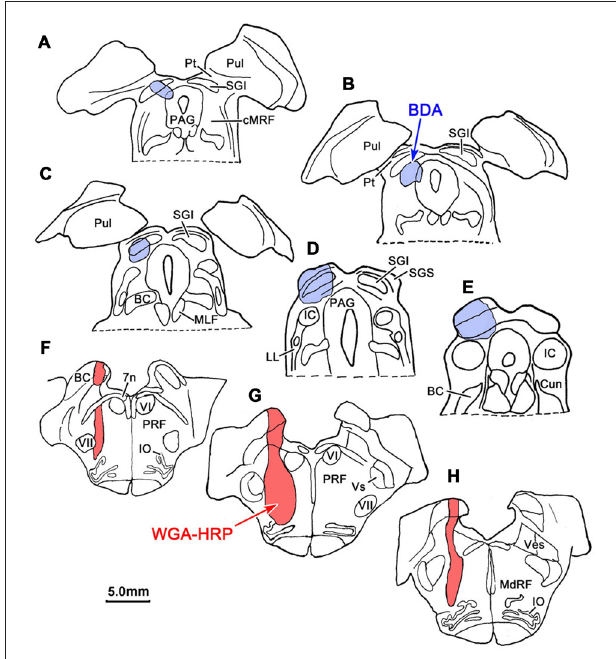
FIGURE 10 | Injection sites for a dual tracer case indicated on a rostral to caudal series of sections. BDA was injected into the superior colliculus (SC; Blue area in A–E ) and WGA-HRP was injected into the lateral PRF (Red area in F–H